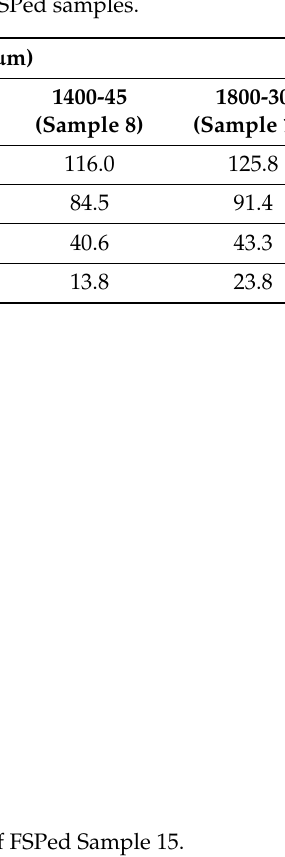
Table 3. Average grain size of recycled AA 6063 base metal and FSPed samples.